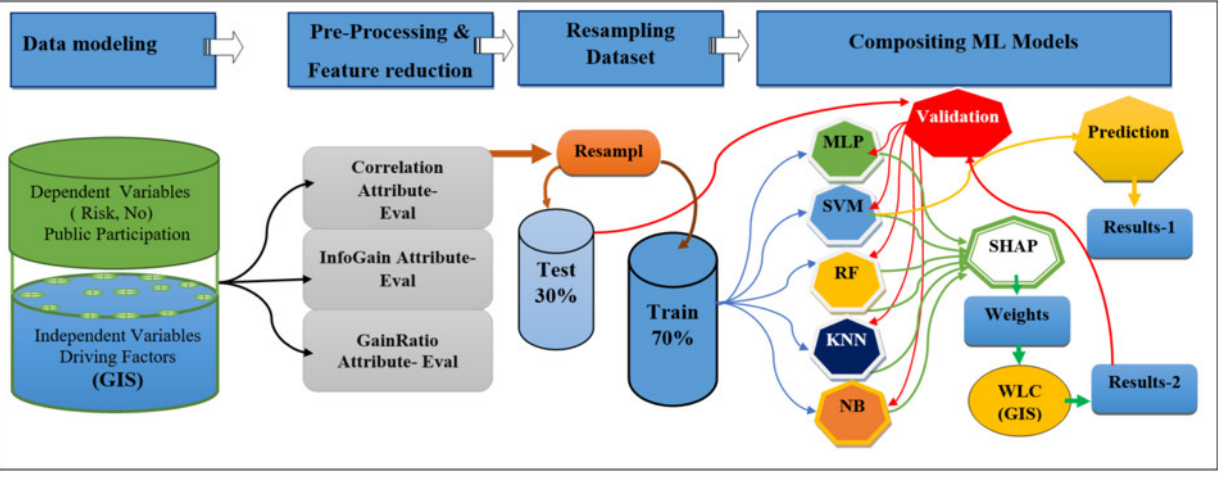
Figure 4. Methodology of the data modelling in this work.